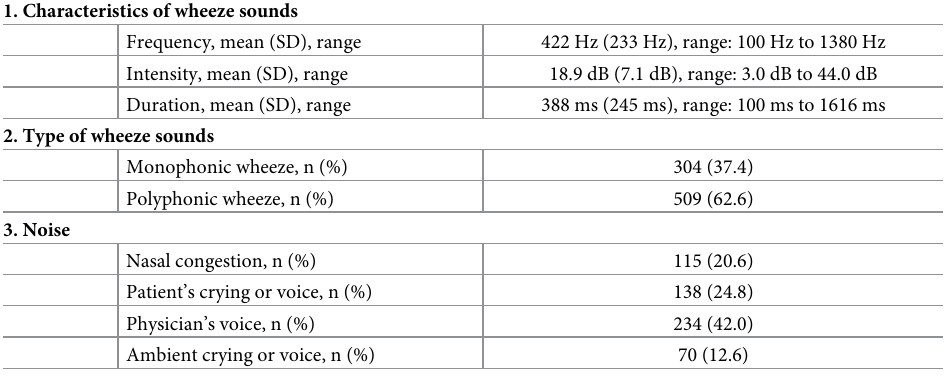
Table 2. Classification of sounds in all recorded sound